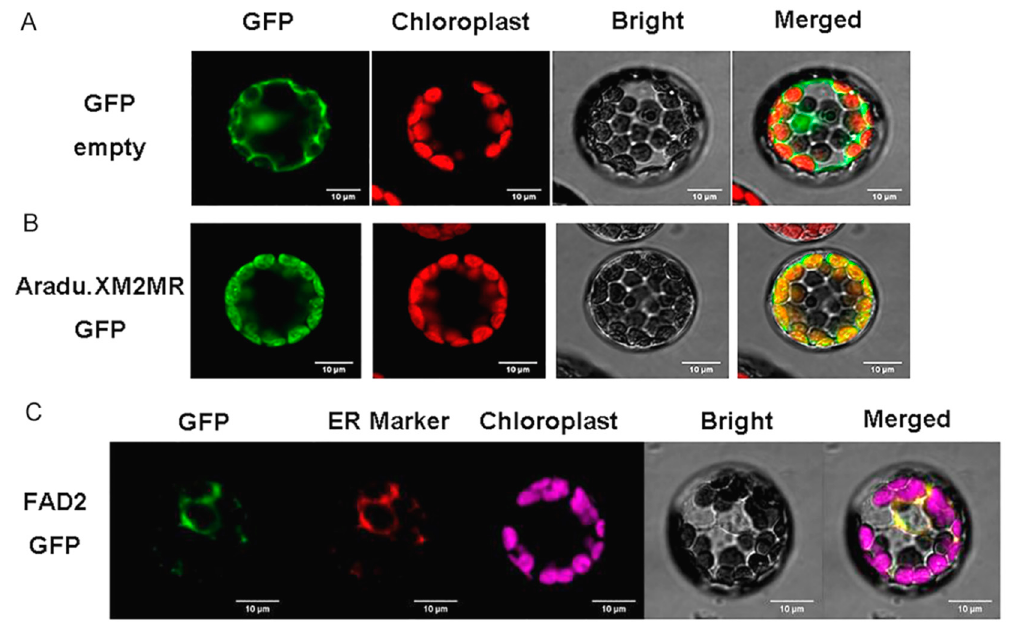
Figure 5. Subcellular localization analysis of FAD2 and Aradu.XM2MR in the Arabidopsis protoplast cell. ( A ) An empty GFP vector served as the control. ( B ) Aradu.XM2MR -GFP (green) merged with chloroplast marker (red) to generate a yellow signal. ( C ) FAD2 -GFP (green), endoplasmic reticulum (ER) marker (red), chlorophyll autofluorescence (pink), and the bright field image were recorded and the resulting images were merged. Scale bar is 10 µm.